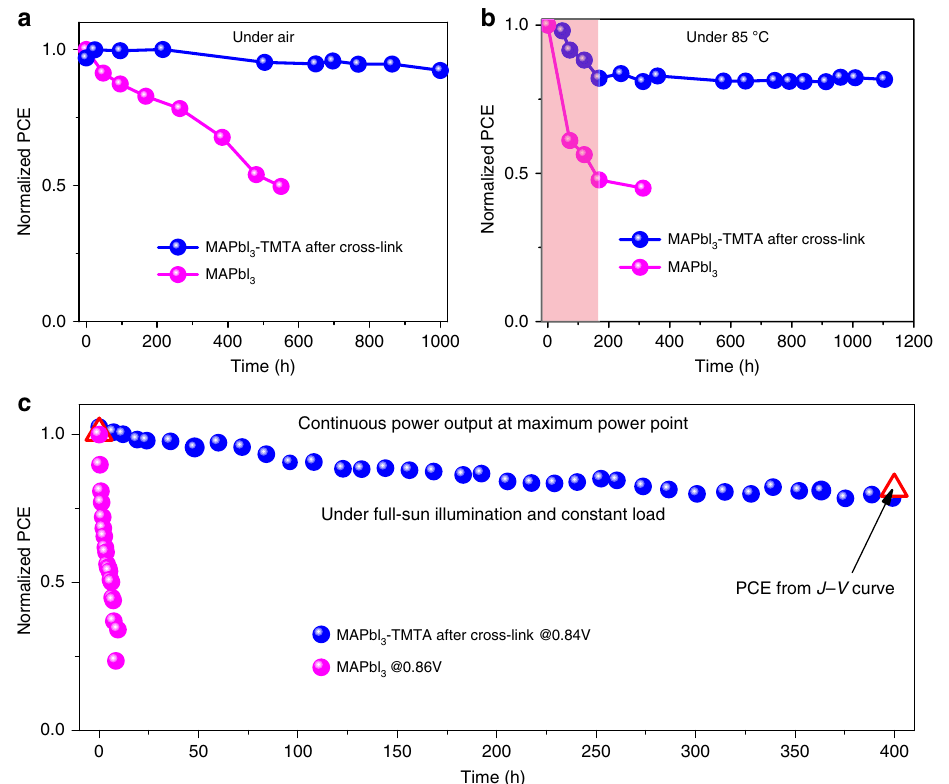
Fig. 5 Long-term stability. a Air stability of non-encapsulated PSCs based on cross-linked MAPbI 3 – TMTA and control MAPbI 3 . The devices are kept in air (relative humidity: 45 – 60%) and measured regularly in glovebox fi lled with N 2 . b Thermal stability of PSCs based on cross-linked MAPbI 3 – TMTA and control MAPbI 3 . The devices are kept on hotplate (85 °C) in glovebox and measured regularly. c Operational stability of non-encapsulated MAPbI 3 – TMTA (after cross-linking) and control MAPbI 3 based PSCs. The devices are examined at maximum power point with a constant load (0.84 V, 0.86 V for MAPbI 3 – TMTA and MAPbI 3 devices respectively) under continuous full-sun, AM 1.5 G illumination in glovebox. Under this condition, the continuous power output is monitored in our PSCs. The red triangle is the devices ef fi ciency obtained from J – V curves. Note that the light source in the operational stability is Xenon lamp (Newport Oriel Sol3A solar simulator, 100 mW cm − 2 ) without any UV fi lter calibrated by a reference solar cell (Newport) and that the external load (0.84 V) and AM 1.5 G illumination is continuously applied on the PSCs except the calibration of light